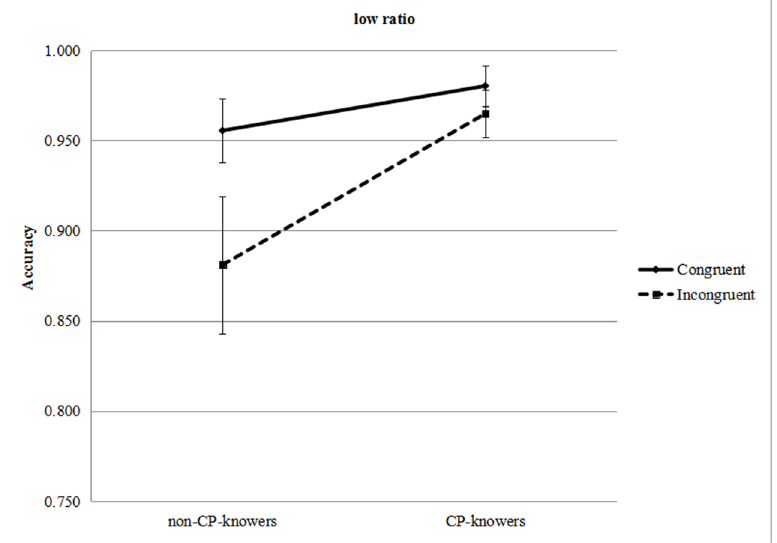
Fig 2. Accuracy results of interaction of CP knowledge and condition in low ratio.(Error bars showed the standard errors).